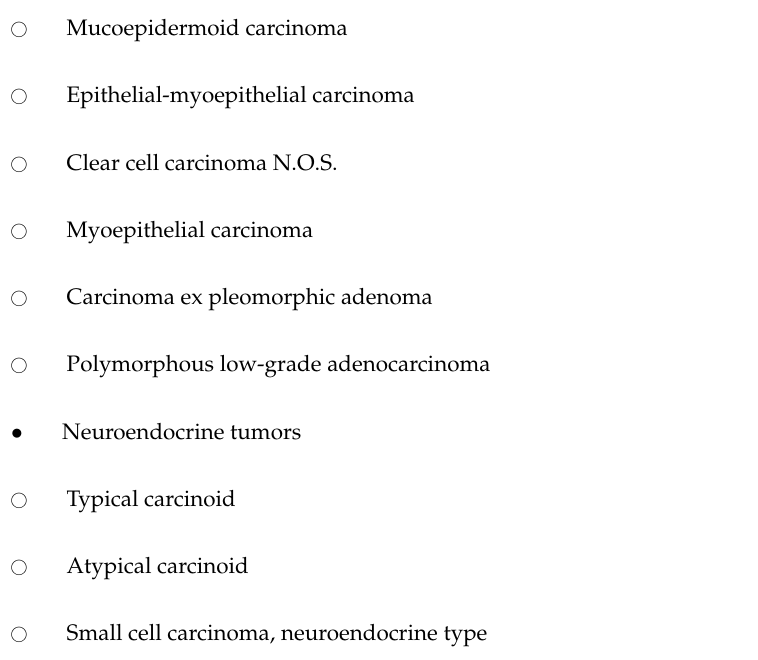
Table 2. Cont . Malignant Epithelial Tumors Benign Epithelial